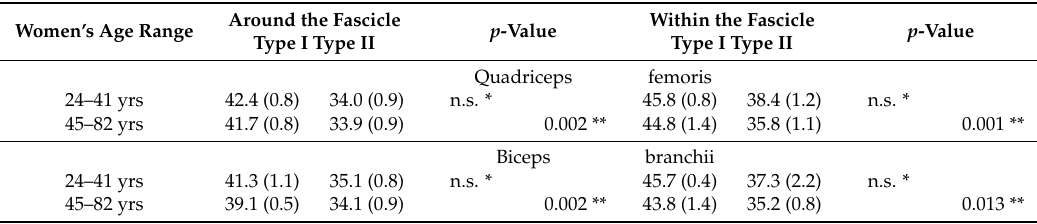
Table 3. Associations of the mean diameter in µ m for both muscle fibers types within and around the fascicle in the sample of postmortem